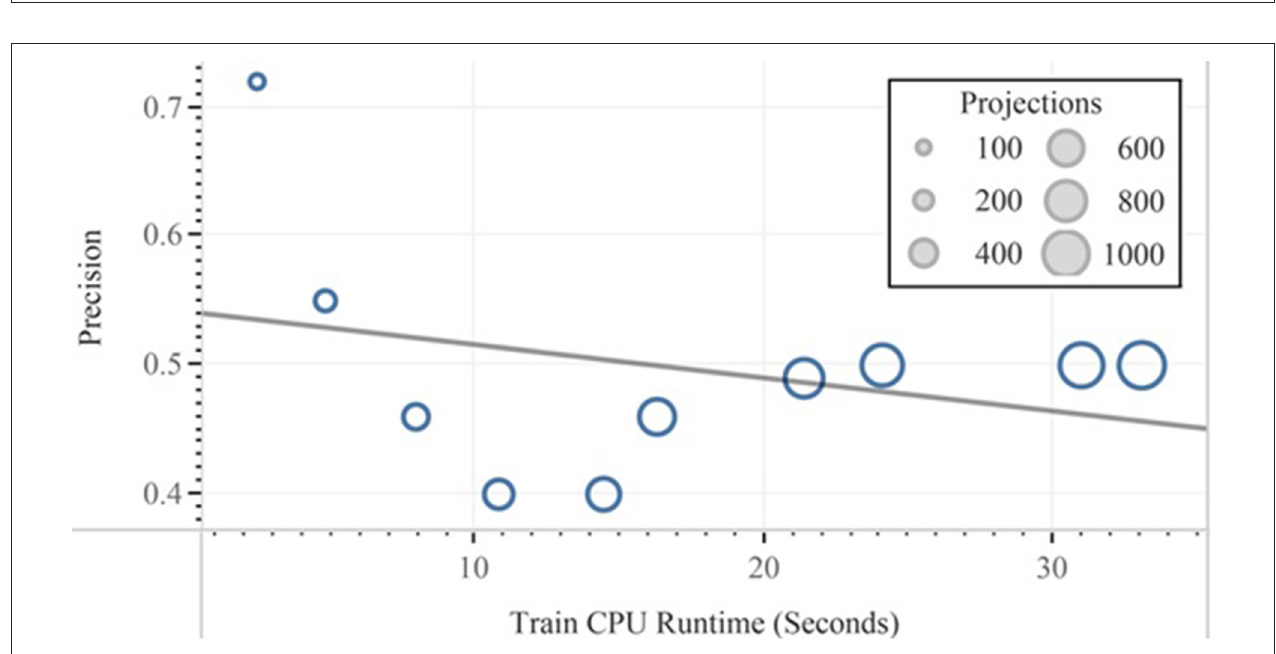
FIGURE 12 | Precision vs. training CPU runtime experimented in FLDA.